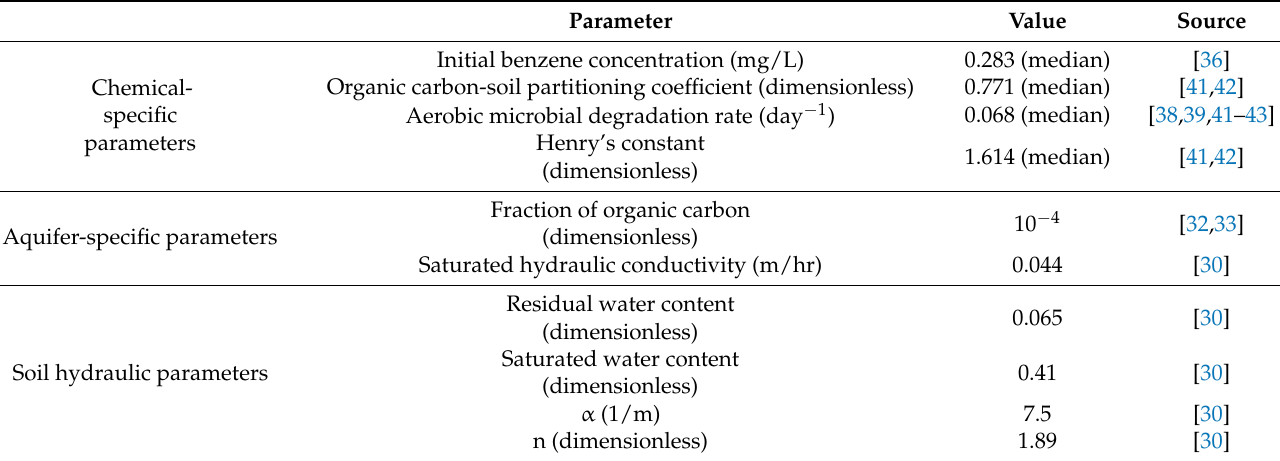
Table 2. Chemical- and soil-specific parameters used for HYDRUS spill size simulations. Parameter Value